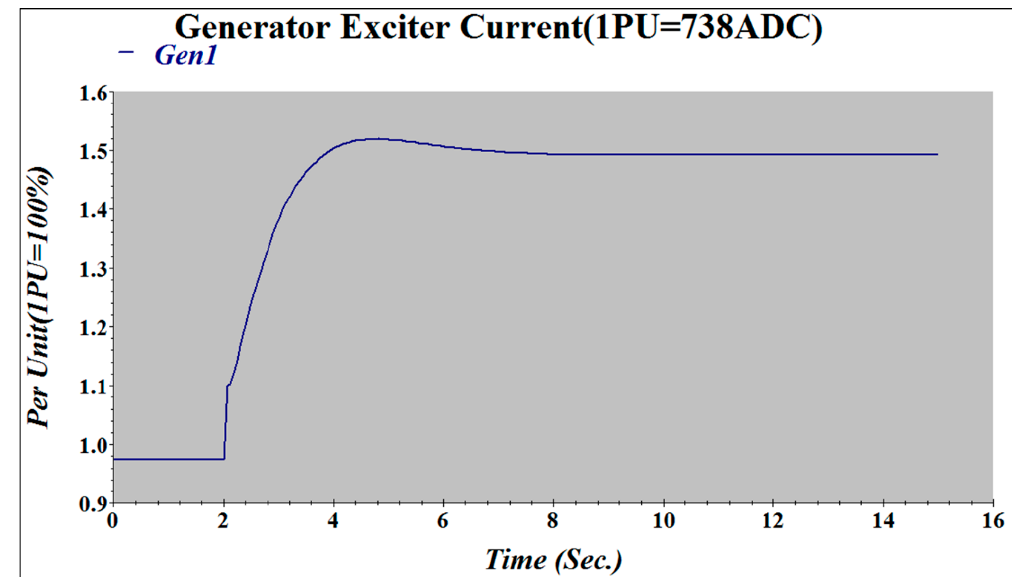
Figure 9. Without OEL (Over Excitation Limit) at − 10% impact in grind.